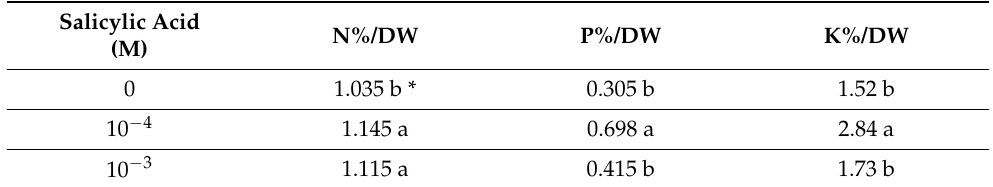
Table 5. Effect of different concentrations of salicylic acid on Nitrogen (N), Phosphorus (P), and Potassium (K) percentage in S. marianum L dried leaves.